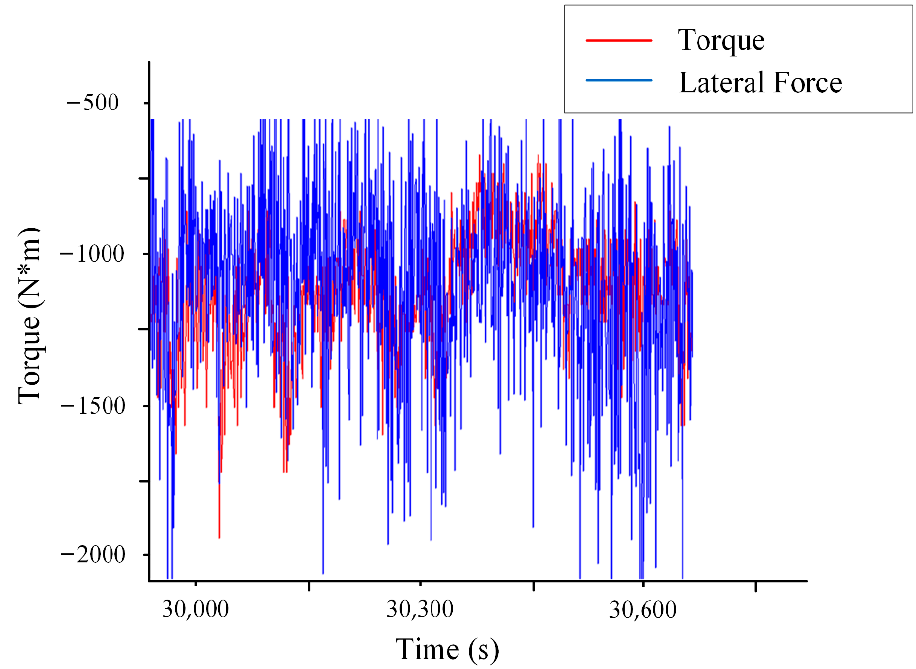
Figure 13. Partial enlargement of relationship between the lateral force and the torque. The working condition of the drill pipe during drilling could also be seen in the relationship diagram of lateral force and torque. The coincidence degree of the lateral force curve and the torque curve in Figure 12 was very high, and the two trends were very similar. In partially enlarged Figure 13, it can be seen more clearly that the lateral force curve and torque curve were at their minimum values near 29,950 s, 30,070 s, 30,150 s, 30,225 s, 30,350 s, and other times, while they were at their maximums near 30,000 s, 30,130 s, 30,300 s, 30,400 s, and other times. The overall trend of the two was the